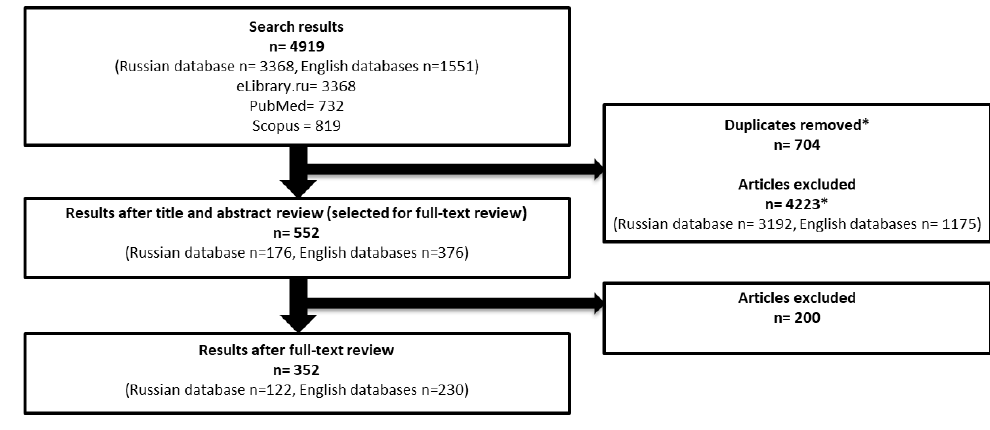
Figure 3. The review screening process: initial search results, articles selected for a full text review, and articles included in the review.